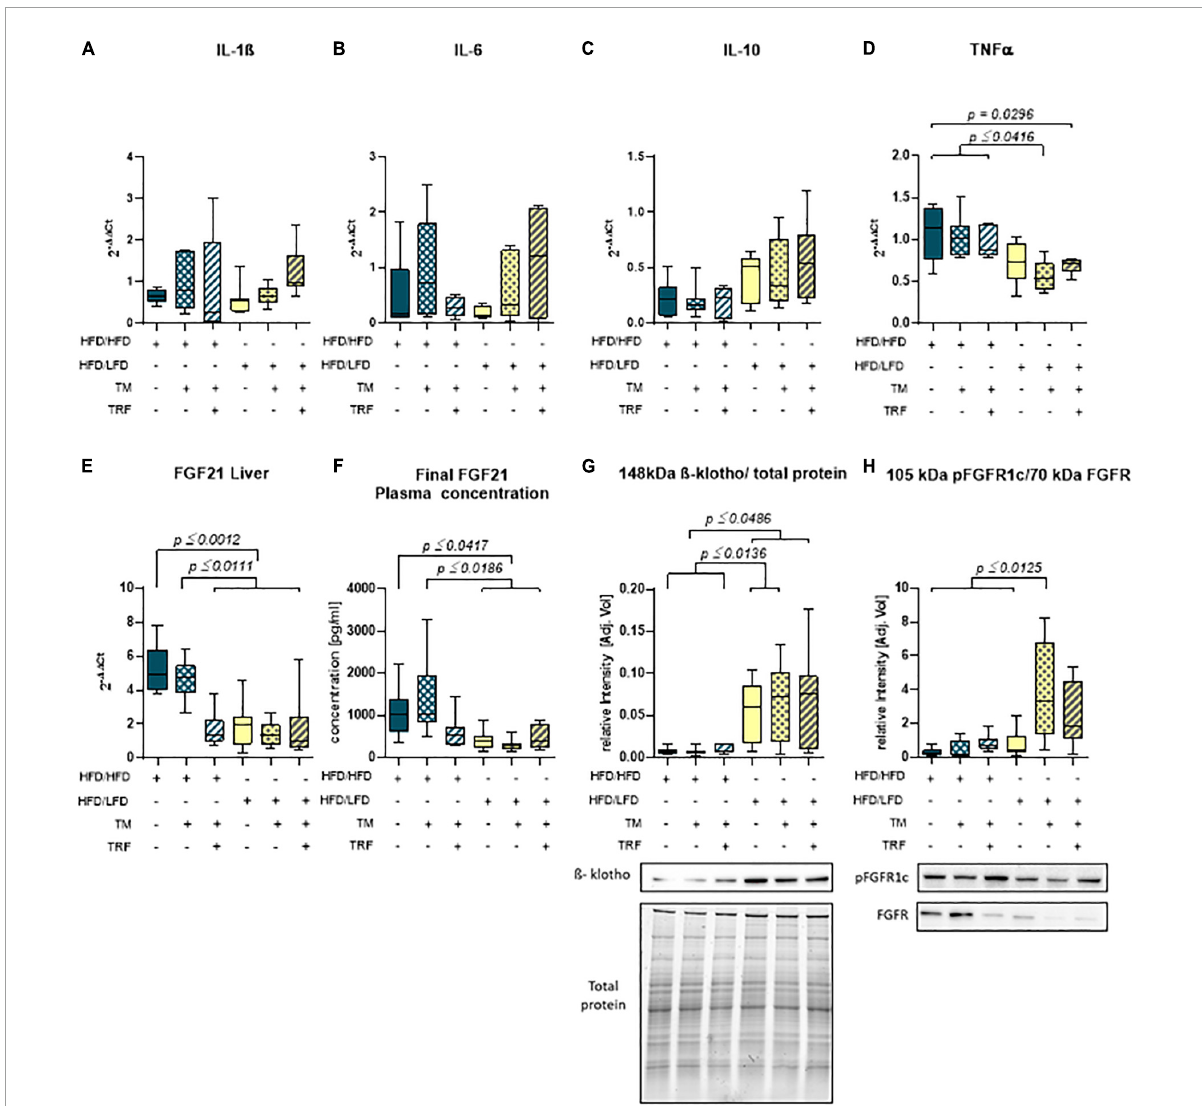
FIGURE5 Hepatic mRNA expression of IL-1 β (A) (HFD/HFD: n = 6, HFD/HFD + TM: n = 7, HFD/HFD + TM + TRF: n = 7, HFD/LFD: n = 7, HFD/LFD + TM: n = 7, HFD/LFD + TM + TRF: n = 7; total n = 41), IL-6 (B) (HFD/HFD: n = 6, HFD/HFD + TM: n = 7, HFD/HFD + TM + TRF: n = 7, HFD/LFD: n = 6, HFD/LFD + TM: n = 7, HFD/LFD + TM + TRF: n = 7; total n = 40), IL-10 (C) (HFD/HFD: n = 7, HFD/HFD + TM: n = 7, HFD/HFD + TM + TRF: n = 6, HFD/LFD: n = 7, HFD/LFD + TM: n = 7, HFD/LFD + TM + TRF: n = 7; total n = 41), TNF α (D) (HFD/HFD: n = 6, HFD/HFD + TM: n = 7, HFD/HFD + TM + TRF: n = 7, HFD/LFD: n = 7, HFD/LFD + TM: n = 7, HFD/LFD + TM + TRF: n = 7; total n = 41), plasma concentration (E) (HFD/HFD: n = 13, HFD/HFD + TM: n = 13, HFD/HFD + TM + TRF: n = 15, HFD/LFD: n = 12, HFD/LFD + TM: n = 14, HFD/LFD + TM + TRF: n = 11; total n = 78), and hepatic mRNA expression (F) (HFD/HFD: n = 6, HFD/HFD + TM: n = 6, HFD/HFD + TM + TRF: n = 7, HFD/LFD: n = 7, HFD/LFD + TM: n = 7, HFD/LFD + TM + TRF: n = 7; total n = 40) of FGF21. Data presented as 2 - (cid:49)(cid:49) Ct values determined by quantitative real-time PCR. Quantitative analysis of hepatic protein expression of β -klotho (G) (HFD/HFD: n = 12, HFD/HFD + TM: n = 9, HFD/HFD + TM + TRF: n = 10, HFD/LFD: n = 12, HFD/LFD + TM: n = 15, HFD/LFD + TM + TRF: n = 11; total n = 69) and phosphorylated form of the FGF receptor (H) (HFD/HFD: n = 12, HFD/HFD + TM: n = 10, HFD/HFD + TM + TRF: n = 10, HFD/LFD: n = 9, HFD/LFD + TM: n = 10, HFD/LFD + TM + TRF: n = 8; total n = 59) both with representative Western blots. Signals were normalized either to total protein ( β -klotho) or to the non-phosphorylated FGF receptor. Blue dots and box plots indicate HFD groups, and yellow dots and box plots indicate dietary change to LFD. Table displays the individual groups, respectively. Table is read from top to bottom, and “+” denotes implementation of a given diet or intervention and “ − ” its absence. Significance of differences between groups was tested with either the Kruskal–Wallis test, followed by Dunn’s post hoc test for multiple comparisons (B) , Brown–Forsythe, and Welch’s ANOVA with the Tamhane T2 post hoc test for multiple comparisons [ A: F value ( F ) = 1.165, degree of freedom (DF) = 5; D: F = 5.742, DF = 5. E: F = 11.65, DF = 5, F: F = 9.902, DF = 5 G: F = 10.33; DF = 5, H: F = 9.214; DF = 5], or by ordinary one-way ANOVA with Tukey’s post hoc test for multiple comparisons (C) . Data are presented as mean ± SD, and statistical significance was set at p < 0.05. HFD, high-fat diet; LFD, low-fat diet; TM, treadmill; TRF, time-restricted